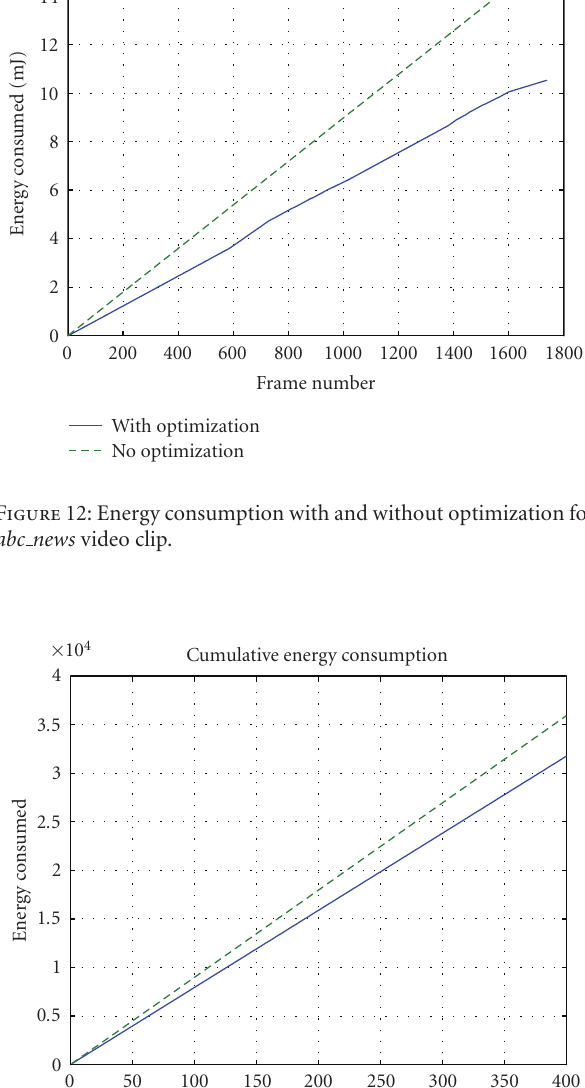
Figure 11: Alfa ∗ adapted to three-given quality thresholds.